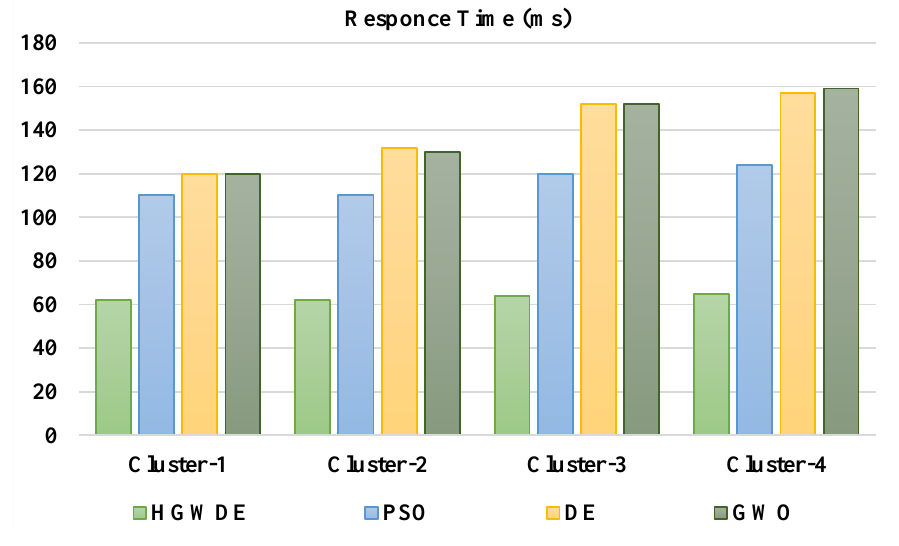
Figure 2. Average response time.